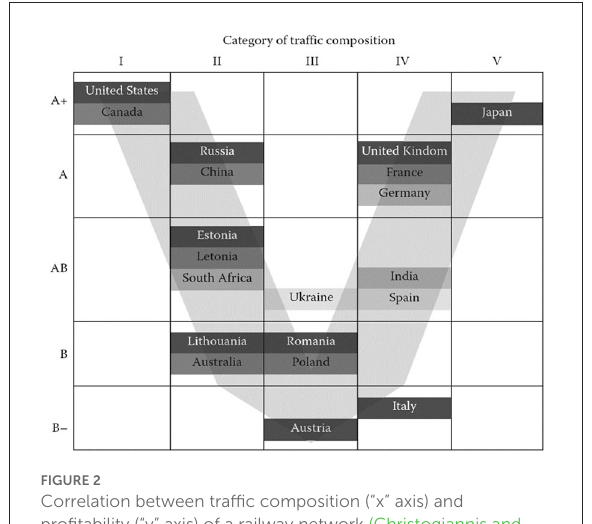
FIGURE2 Correlation between traffic composition (“x” axis) and profitability (“y” axis) of a railway network (Christogiannis and Pyrgidis, 2013,